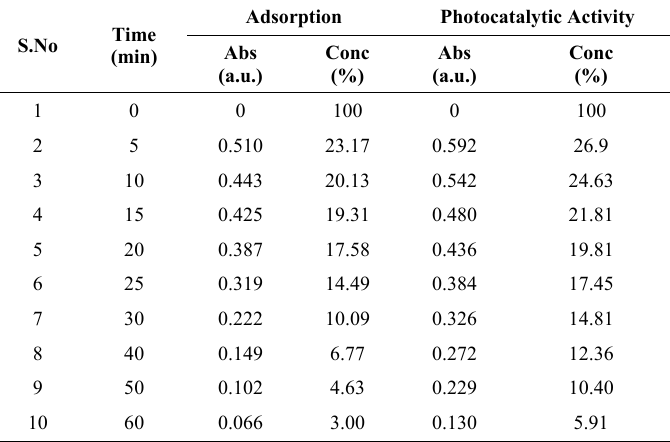
Table 1.The absorbance value with the concentration of the solution for adsorption and photocatalytic